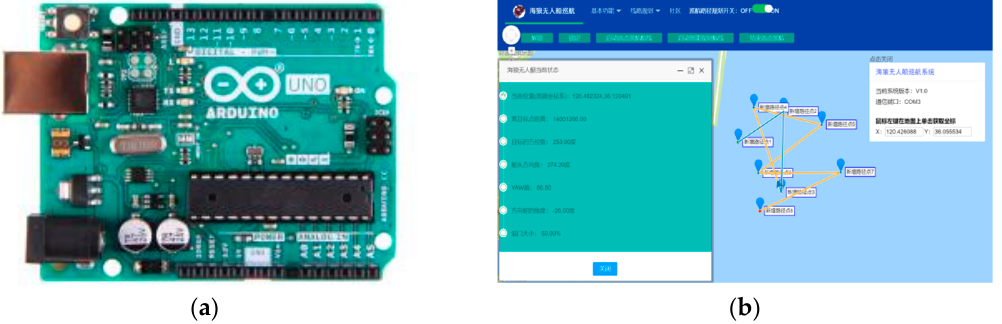
Figure 13. Navigation, guidance, and control system: ( a ) navigation data acquisition system; ( b ) GUI program.